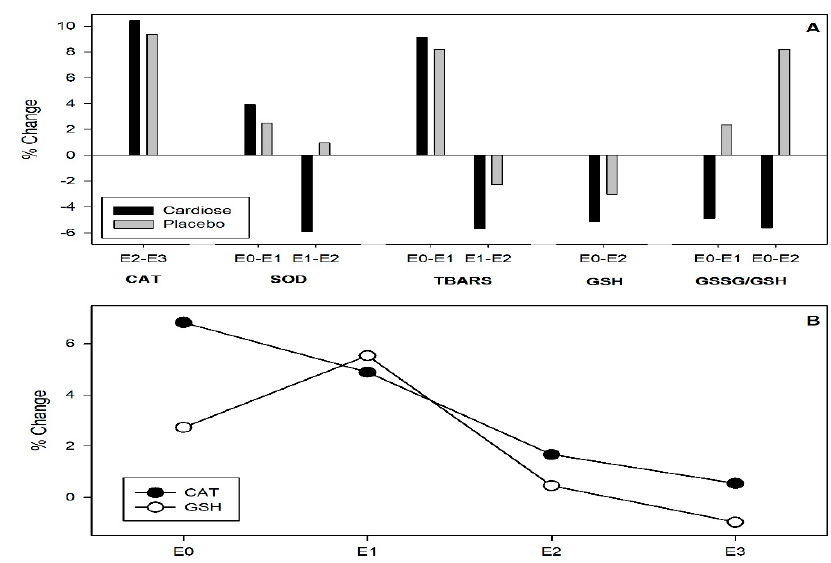
Figure 5. Changes in antioxidants and TBARS measured in repeated sprint test. ( A ) Changes between different time points. ( B ) Changes between treatments. Antioxidant markers were evaluated prior to the testing session (pre VT1 test, and 5 h after supplementation) [E0], post repeated sprint test [E1], post second VT1 test [E2], and 24 h after the end of the testing session [E3]. 377 No significant decrease in GSH levels during the exercise protocol was observed in both